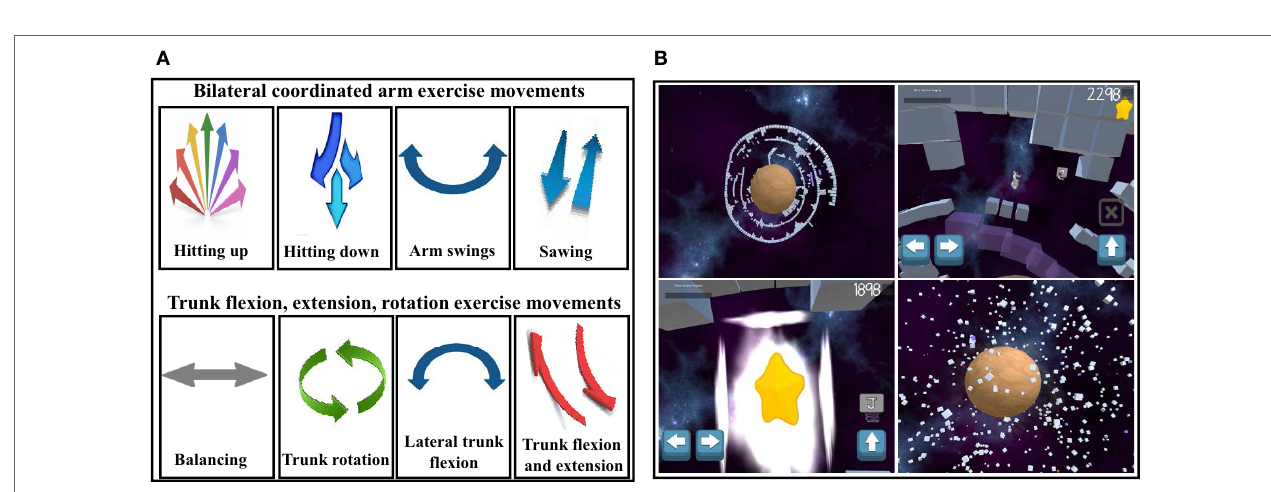
FigUre 6 | The programmable iPadAir accelerometer and gyroscopic motion features facilitate incorporation of specific upper extremity and trunk exercise motions for (a) exercise motions needed to overcome a specific mini-game challenge and (B) exercises for 30 s “power-ups” to provide the energy needed to continue gameplay, as illustrated in the Planet Puzzle mini-game sequences.